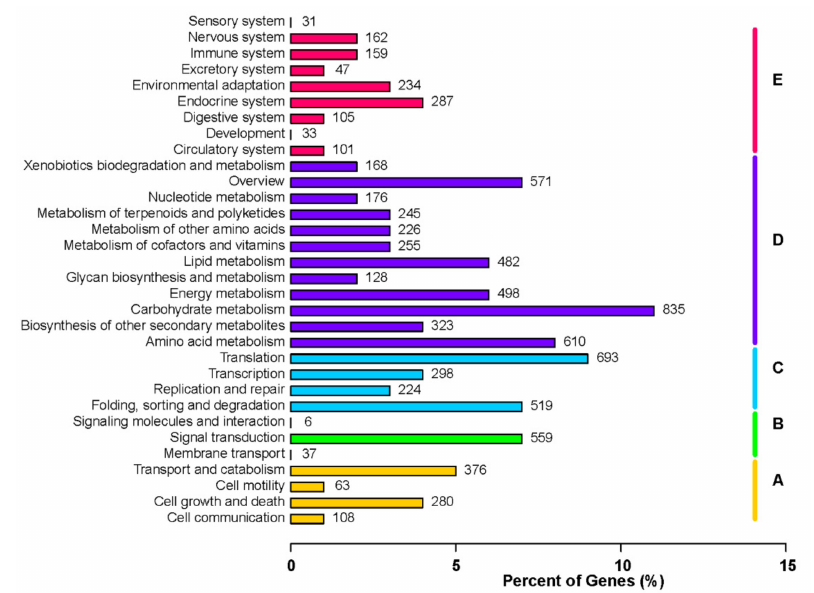
Figure 5. Functional annotation of unigenes based on the Kyoto Encyclopedia of Genes and Genomes (KEGG) categorizations. Main functional categories are summarized as follows: ( A ) cellular processes, ( B ) environmental information processing, ( C ) genetic information processing, ( D ) metabolism, and ( E ) organismal systems. Bars represent the number of Platycladus orientalis unigenes with BLASTX matches to KEGG pathways. The x-axis indicates the number of genes annotated with a particular pathway out of the total number of annotated genes